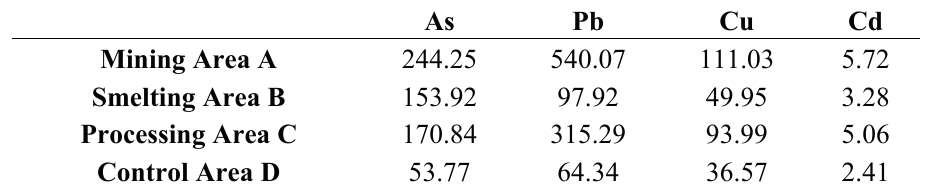
Table 4. Mean concentrations of heavy metals in soils from different functional areas (mg/kg